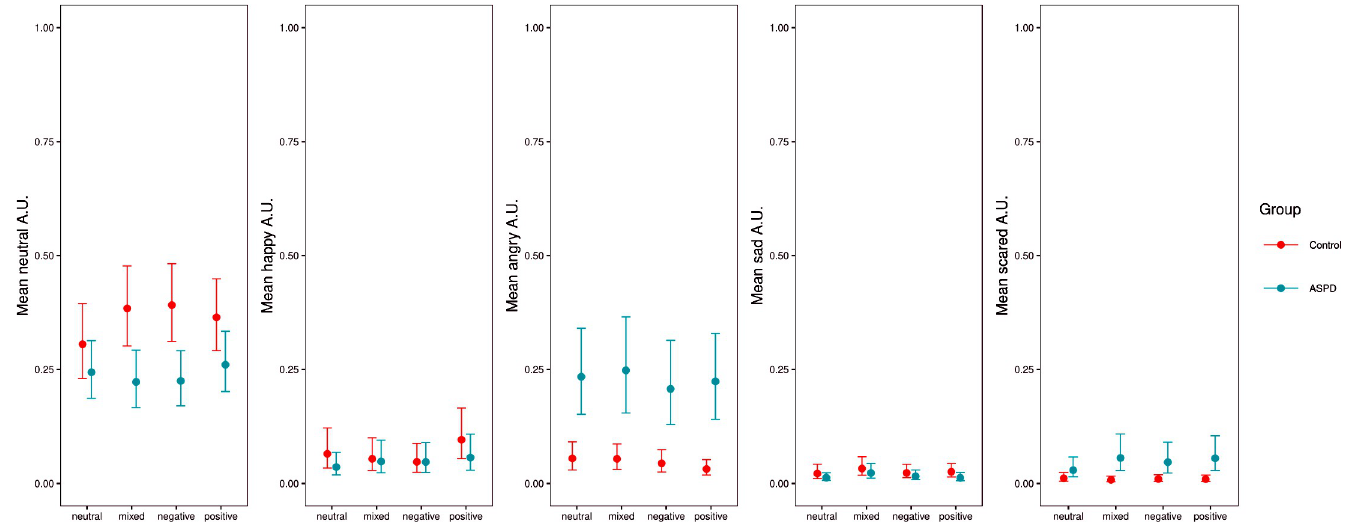
Fig 2. Posterior distribution of the mean with a median point estimate and 95% credible interval (thinner outer lines) of Model 2 (R/conditional effects R, [49]).